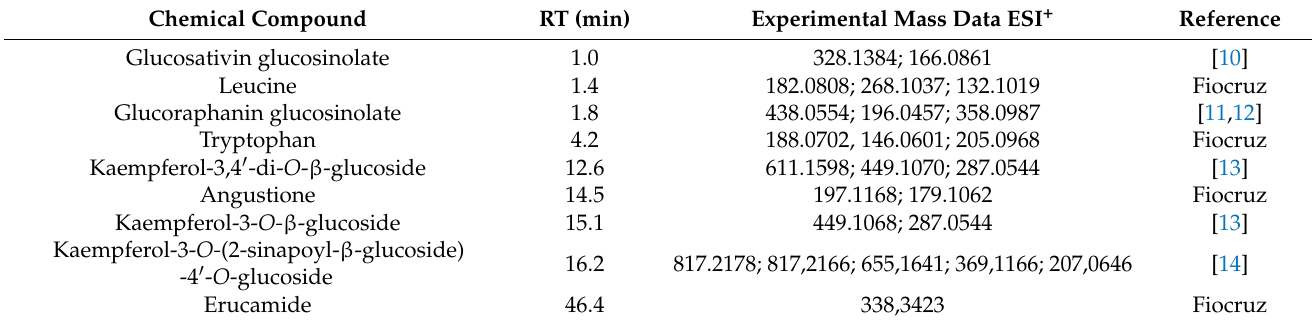
Table 1. Substances identified by UHPLC-ESI-QTOF in the ethanolic extract of Eruca sativa